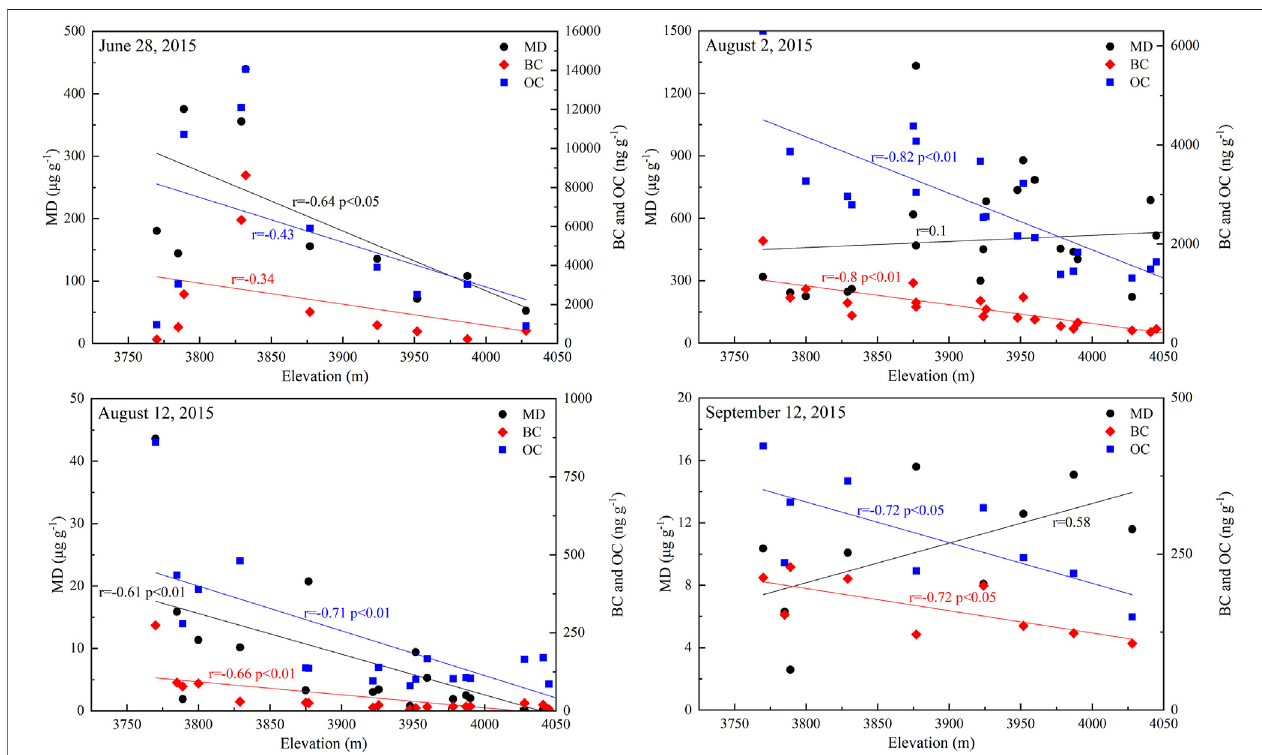
FIGURE 5 | Correlations between LAIs and the sampling elevations on the east branch of Urumqi Glacier No.1. Note that the scales were different for different sampling dates.